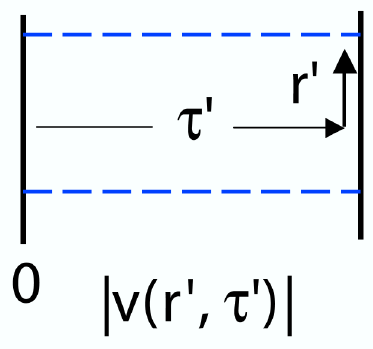
FIG. 4. (Color) Contours of constant virtual field amplitude j v j as a function of expanding coordinates (cid:3) r 0 ; (cid:3) 0 (cid:5) for free-space diffraction of a spherical wave front. The dashed lines indicate the constant size of the integration steps in the primed coordinate system. Also notice that a spherical wave maintains a nearly constant radius in this coordinate